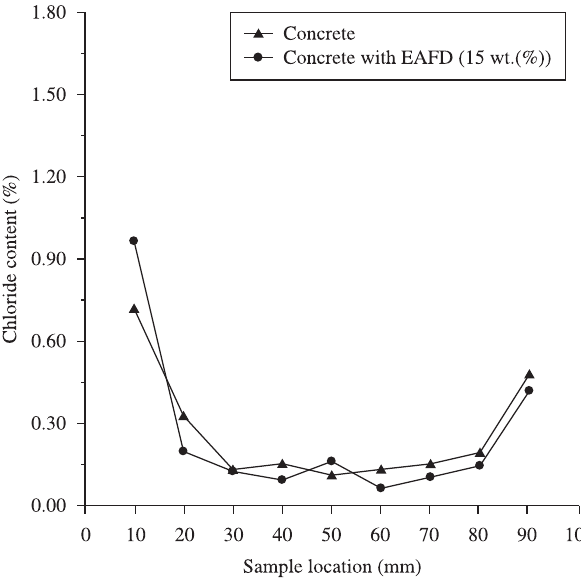
Figure 9. Chloride penetration profiled (percent of chloride per cement weight) in the cylindrical samples after 30 days immersion in NaCl Table 6. Average chloride content (in %) at 30 to 40 mm of the cylindrical samples. Immersion time (days)